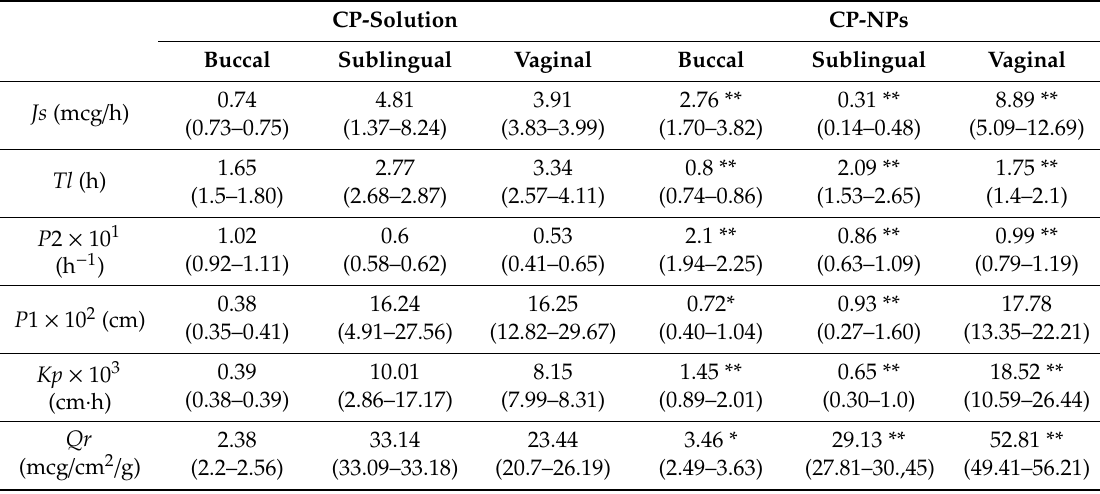
Table 3. Median, maximum and minimum values of flux ( Js ), lag time ( Tl ), P1, P2, permeability coe ffi cient ( Kp ) and in vivo retained amount ( Qr ) of CP at 6h from the solution of CP (CP-Solution) and nanoparticles of CP (CP-NPs) through mucous membranes (buccal, sublingual and